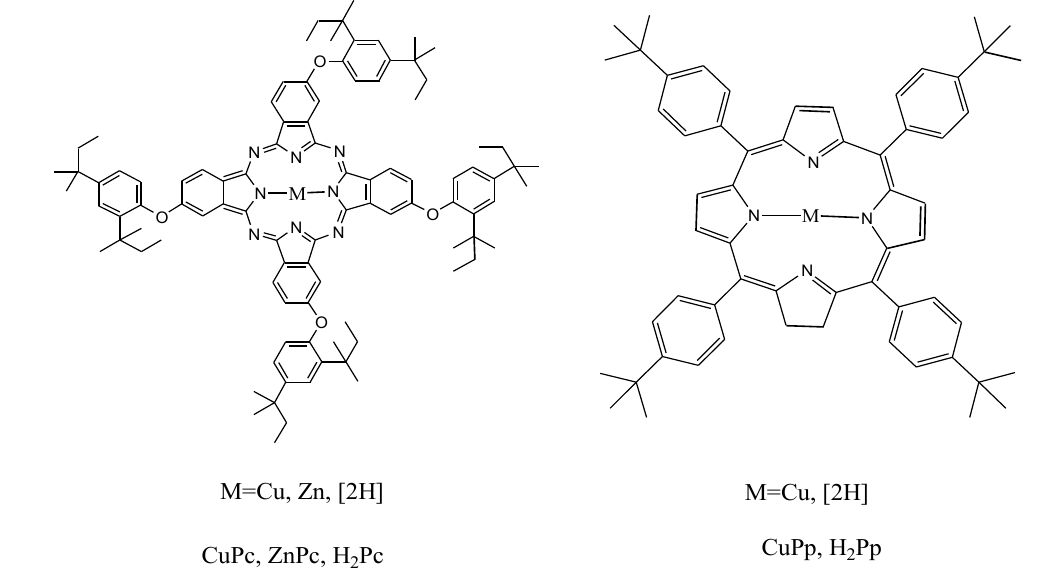
Figure 2. Molecular structure of MPc s and